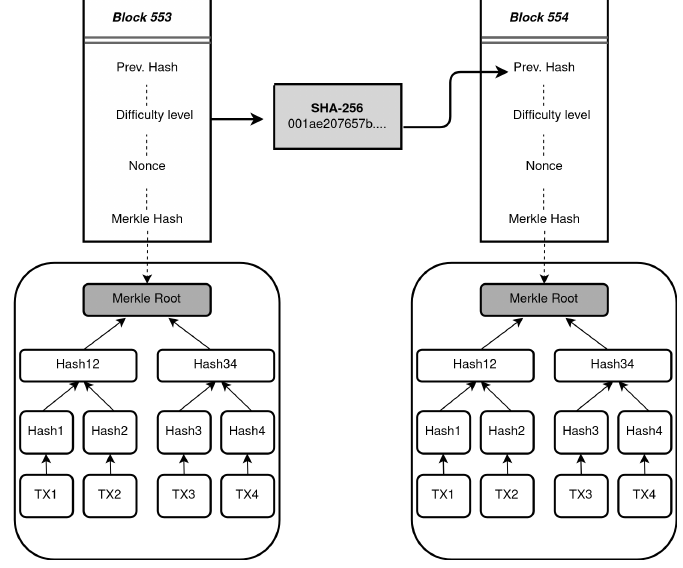
Figure 1. An illustration of Merkle root of bitcoin